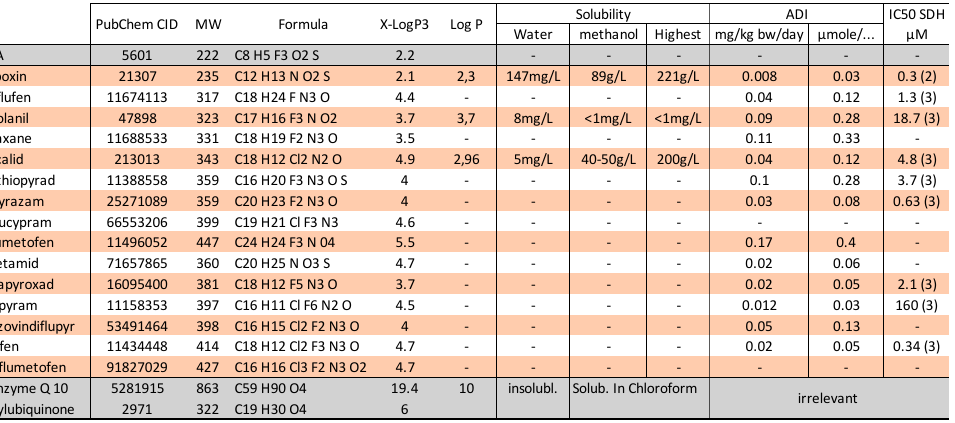
Figure 1. Data were obtained for the largest part from PubChem (https://pubchem.ncbi.nlm.nih.gov/, accessed on 19 December 2022). TTFA, decylubiquinone, and coenzyme Q10 (ubiquinone) are not SDHIs, but are relevant here (gray lines). The other lines (orange/white) list SDHIs presently in use. X-LogP3 is the predicted LogP value obtained by computation. The experimental LogP/LogKow (octanol/water) values and solubility data are indicated when available. ADI (acceptable Daily Intake) indicates the level of the limit for exposure in the general population. The last column shows the IC50 available (2) and (3) refer, respectively, to references [2,3] from which these values were derived.